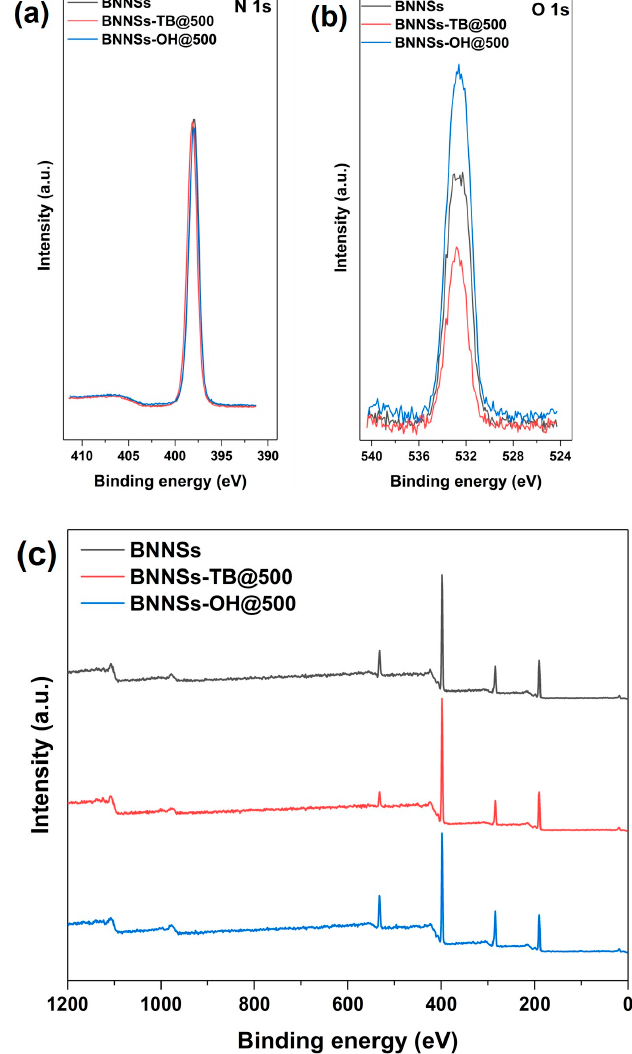
Figure 2. ( a ) N 1s peak in XPS spectra, ( b ) O 1s peak in XPS spectra, and ( c ) XPS spectra of BNNSs,